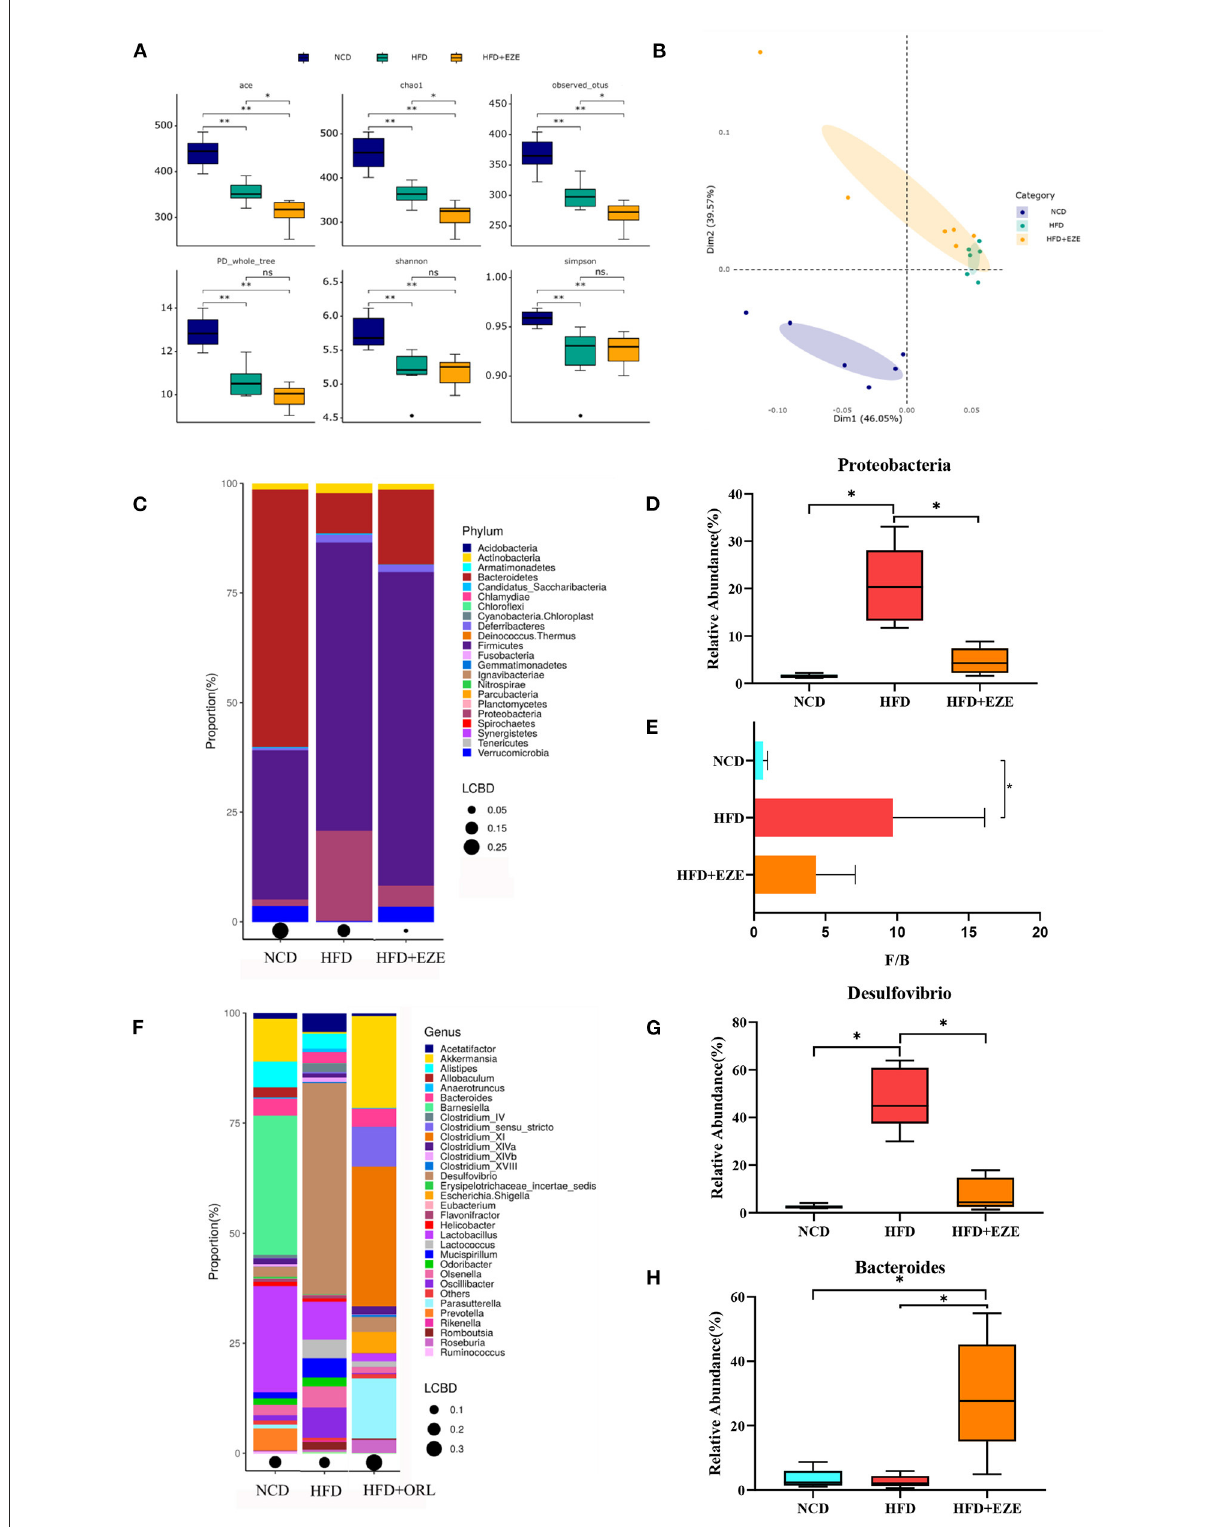
FIGURE6 Alterations in gut microbiota before and after ezetimibe intervention. (A) The α -diversity of fecal microbiota in mice. (B) Beta-diversity was visualized by PCoA analysis. (C) Bar plot of gut microbiota composition at the phylum level. (D) The relative abundance of Proteobacteria was significantly decreased after intervention by Metastas analysis. (E) Firmicutes -to- Bacteroidetes ratio ( F / B ) of mice. (F) Bar plot of gut microbiota